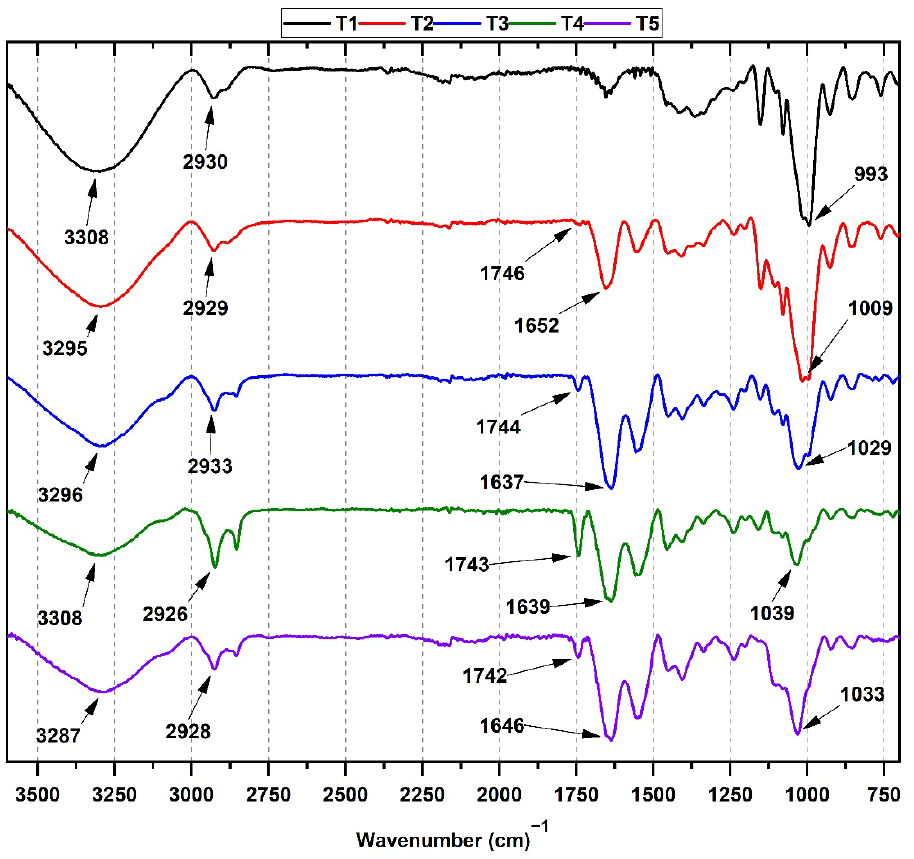
Figure 1. FTIR spectra of cassava starch/gelatin films. T1 gelatin/cassava starch 0/100; T2 gelatin/cassava starch 25/75; T3 gelatin/cassava starch 50/50; T4 gelatin/cassava starch 75/25; T5, gelatin/cassava starch 100/0.